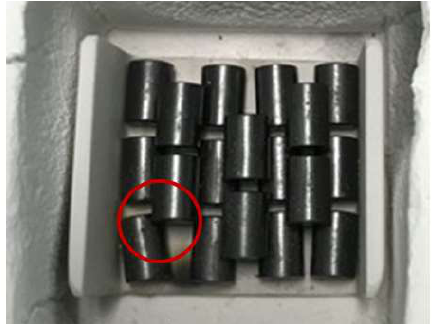
Figure 5. Fuel pellets obtained by microwave sintering in the horizontal position (the red circle - arrangement of tablets with traces of